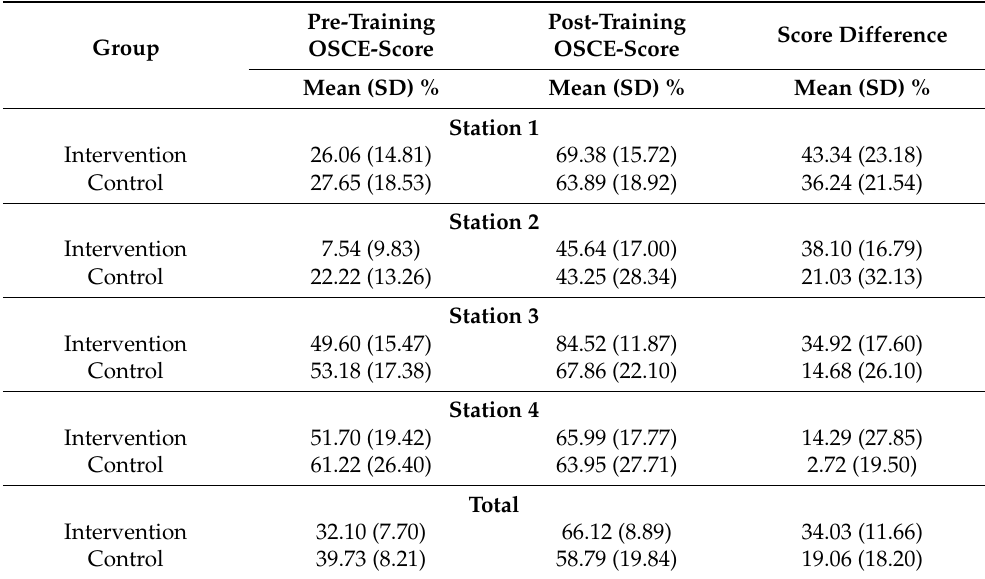
Table 2. Achieved scores by intervention and control group in each station of analytical checklist during pre- and post-Training OSCEs.